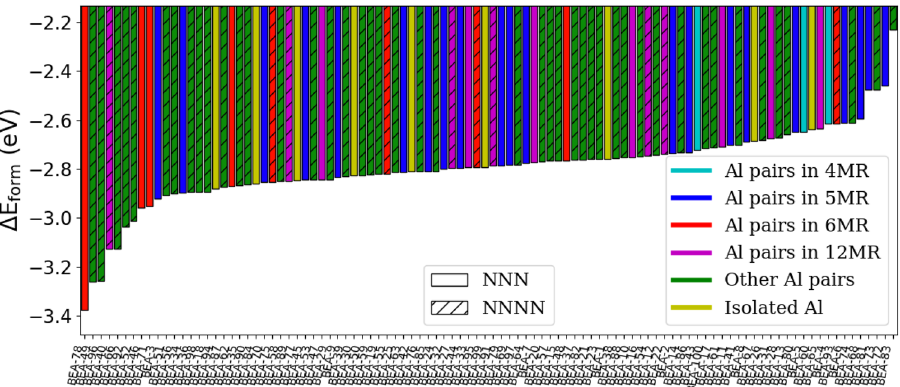
Fig. 7 Formation energy of Pd + /Pd + H + on BEA. Each bar represents unique Al location(s). Color coding refers to the type of Al pairs or isolated Al in the zeolite matrix. In Al pairs, patterned bars refer to Al pairs in NNNN positions and solid colors refer to Al pairs in NNN positions. The most stable site (BEA-78) is illustrated in Fig.